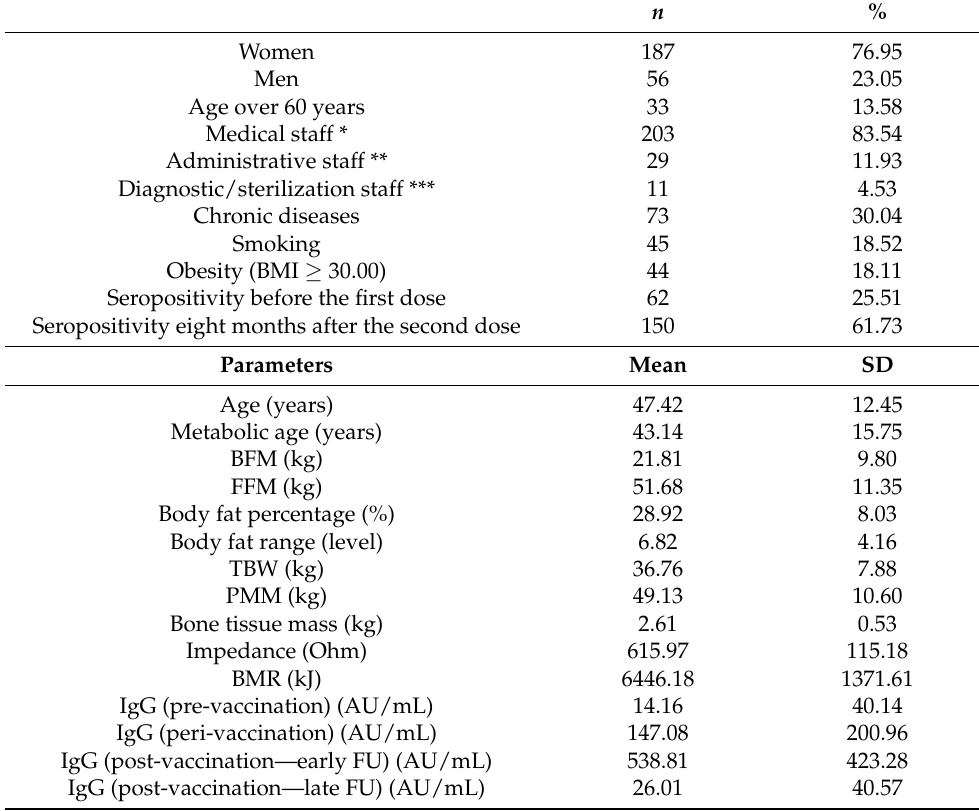
Table 1. Demographic and clinical characteristics of the studied cohort of healthcare